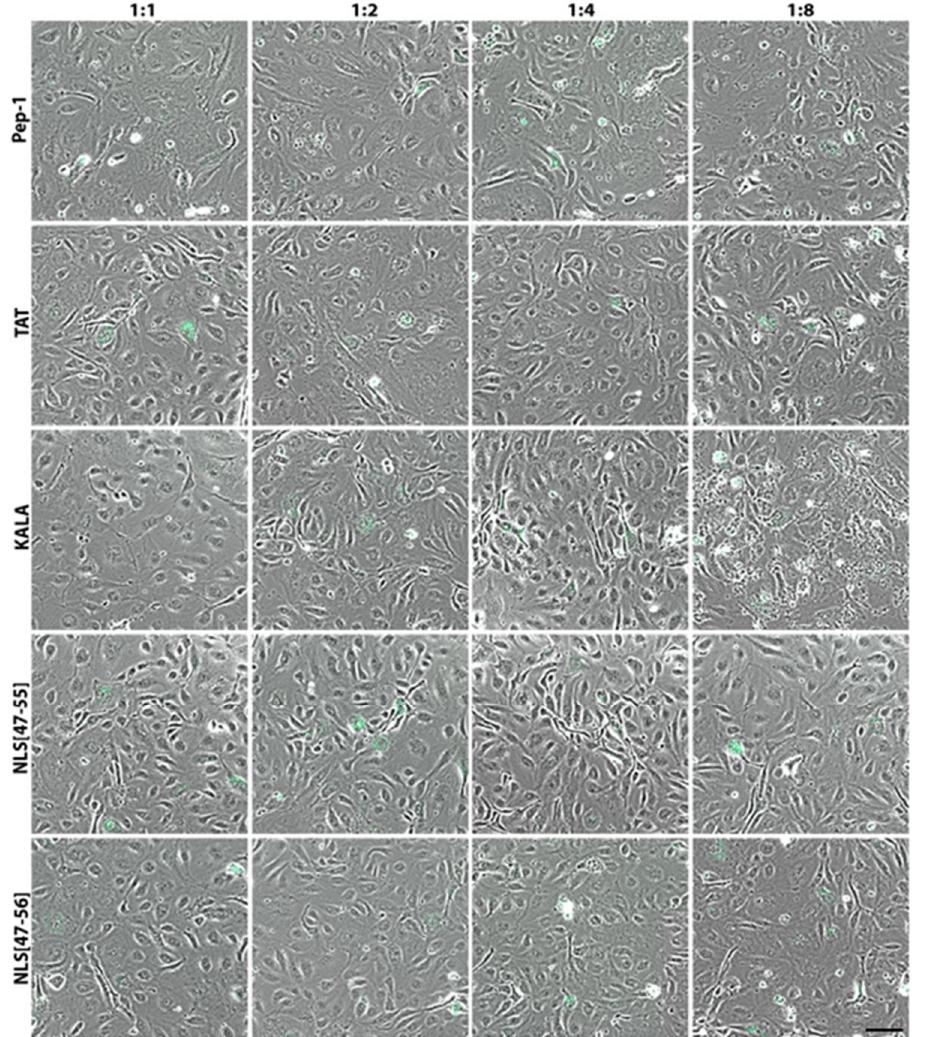
Figure 7. Effect of 24 h culture in the presence of complexes in CRs of 1:1, 1:2, 1:4 and 1:8. The complexes were formed using incubation of 2 μ g pmaxGFP with chosen CPPs at 21 °C for 15 min. CR, charge ratio. ( A ) Transfection efficiency. ( B ) Percent of cells with abnormal morphology. Data are presented as means, numbers in parentheses represent standard deviations.